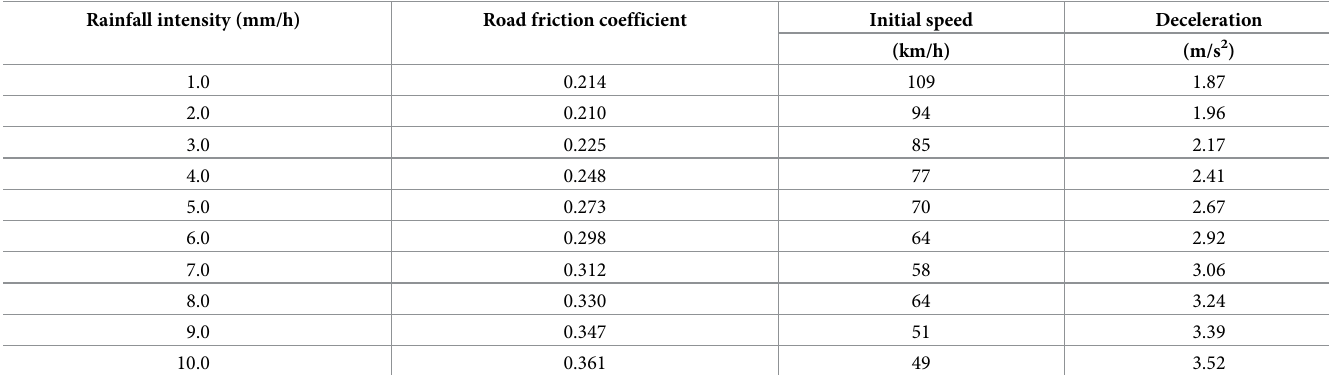
Table 2. The inputs of the simulation test.